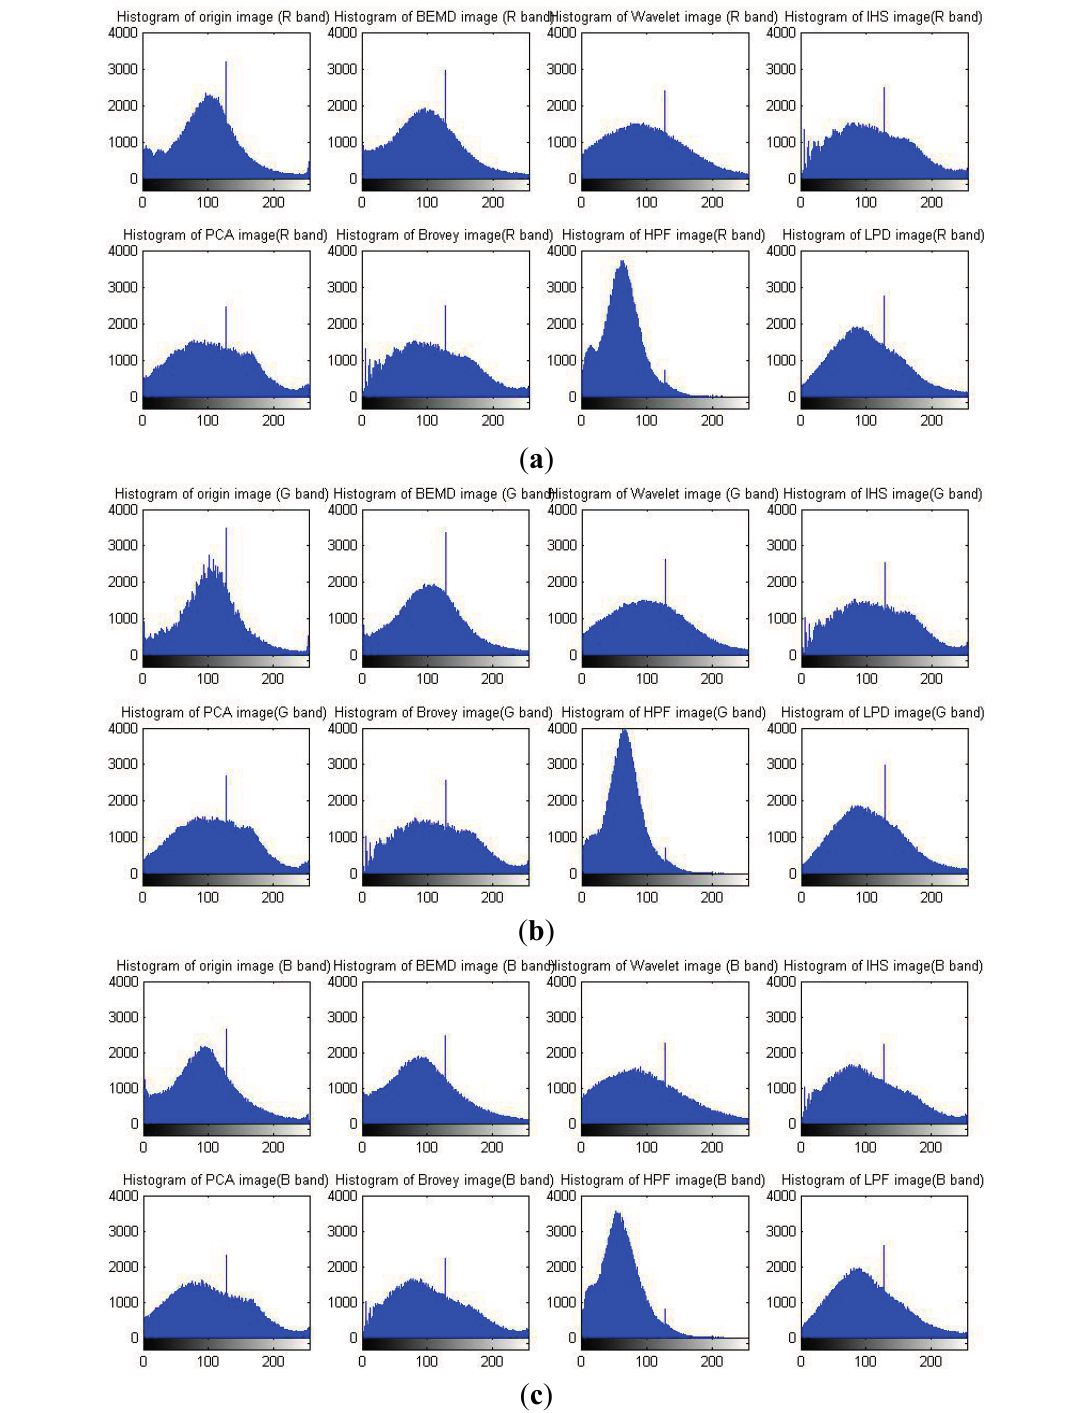
Figure 10. ( a ) Histogram comparison of the R bands (original, BEMD, wavelet, IHS, PCA, Brovey, HPF, LPD). ( b ) Histogram comparison of G bands (original, BEMD, wavelet, IHS, PCA, Brovey, HPF, LPD). ( c ) Histogram comparison of B bands (original, BEMD, wavelet, IHS, PCA, Brovey, HPF,